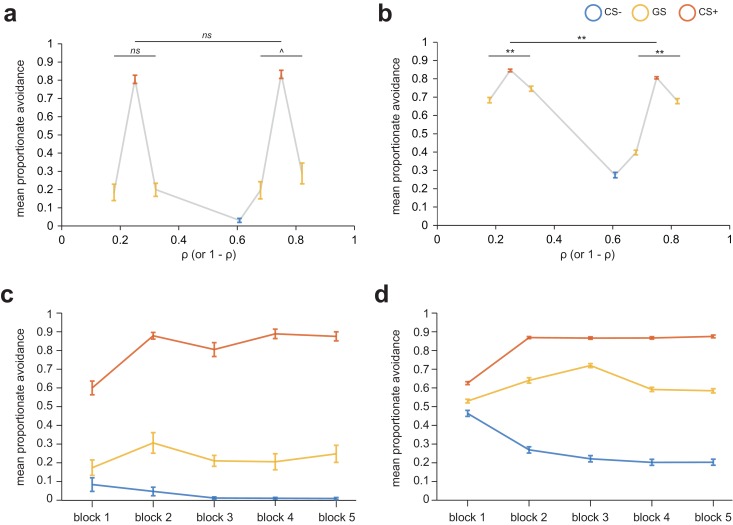
Proportionate avoidance for individiual task stimuli (top row) and by CS type and block number (bottom row) for the generalization of instrumental avoidance task.(a) fMRI, (b) AMT, samples. ns, p>0.3. ^p=0.19, **p<0.001, repeated-measures ANOVA for differences in mean avoidance across generalization stimuli (GSs). (c) fRMI, (d) AMT, samples. Error bars represent standard error.